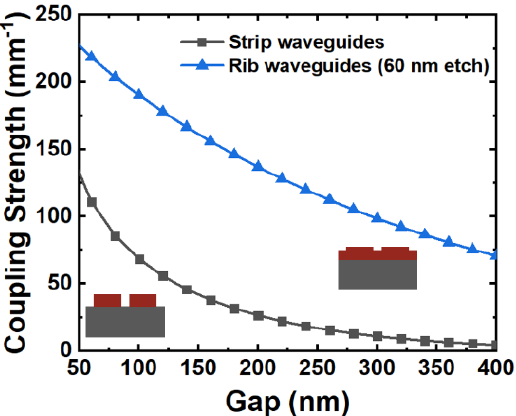
Figure 1. Coupling strength versus gap of two types of waveguide structure. Structures in red and grey are silicon (Si) and buried oxide (BOX), respectively.